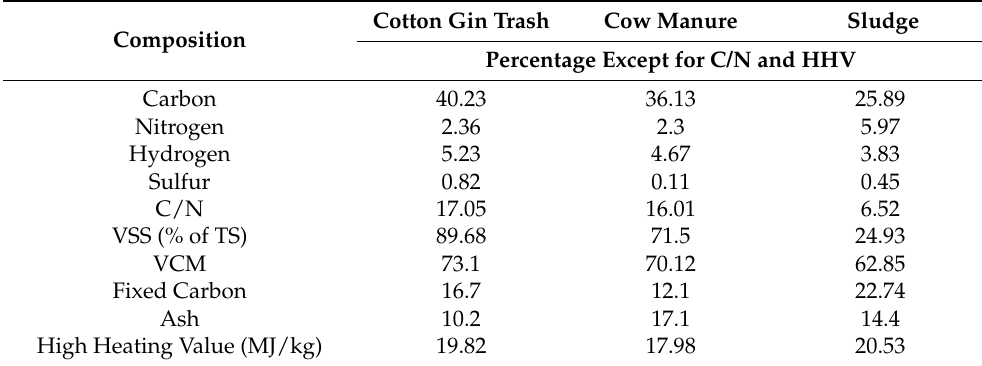
Table 2. Feedstock composition for anaerobic